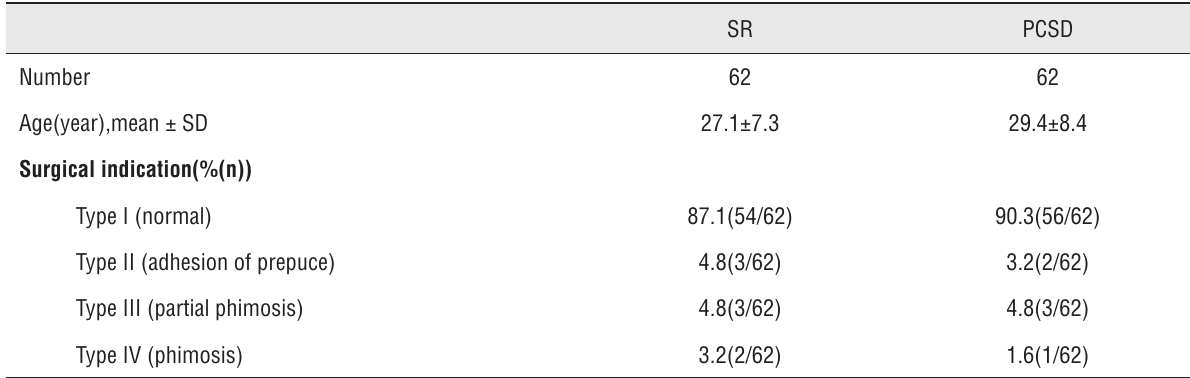
Table 1 - Baseline